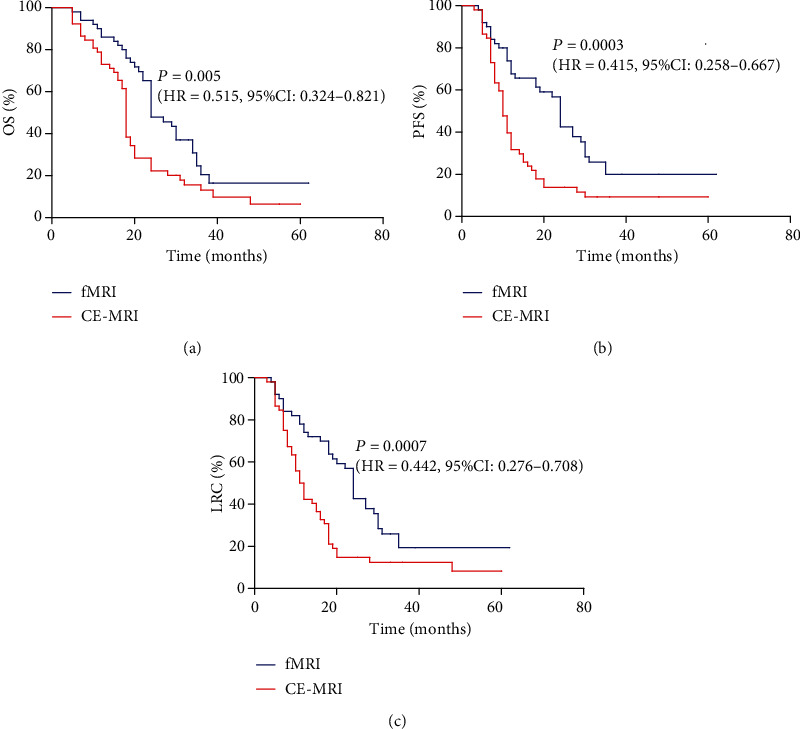
OS, PFS, and LRC for the multimodality MRI and CE-MRI cohorts. (a) OS, (b) PFS, and (c) LRC stratified by multimodality MRI and CE-MRI in 102 patients with HGG.